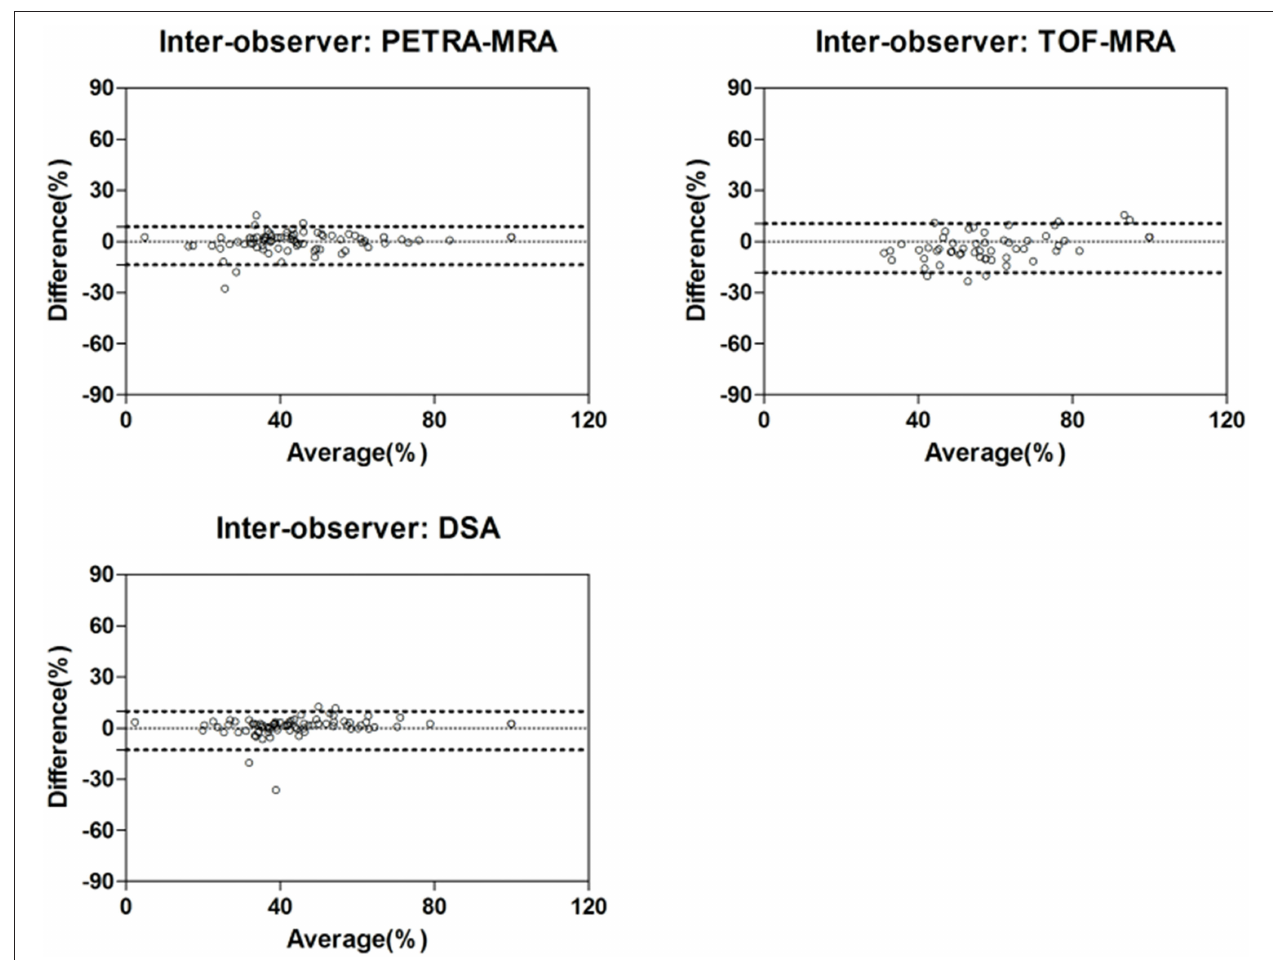
FIGURE 6 | Inter-observer agreement of stenosis measurements using PETRA-MRA, TOF-MRA, and DSA.